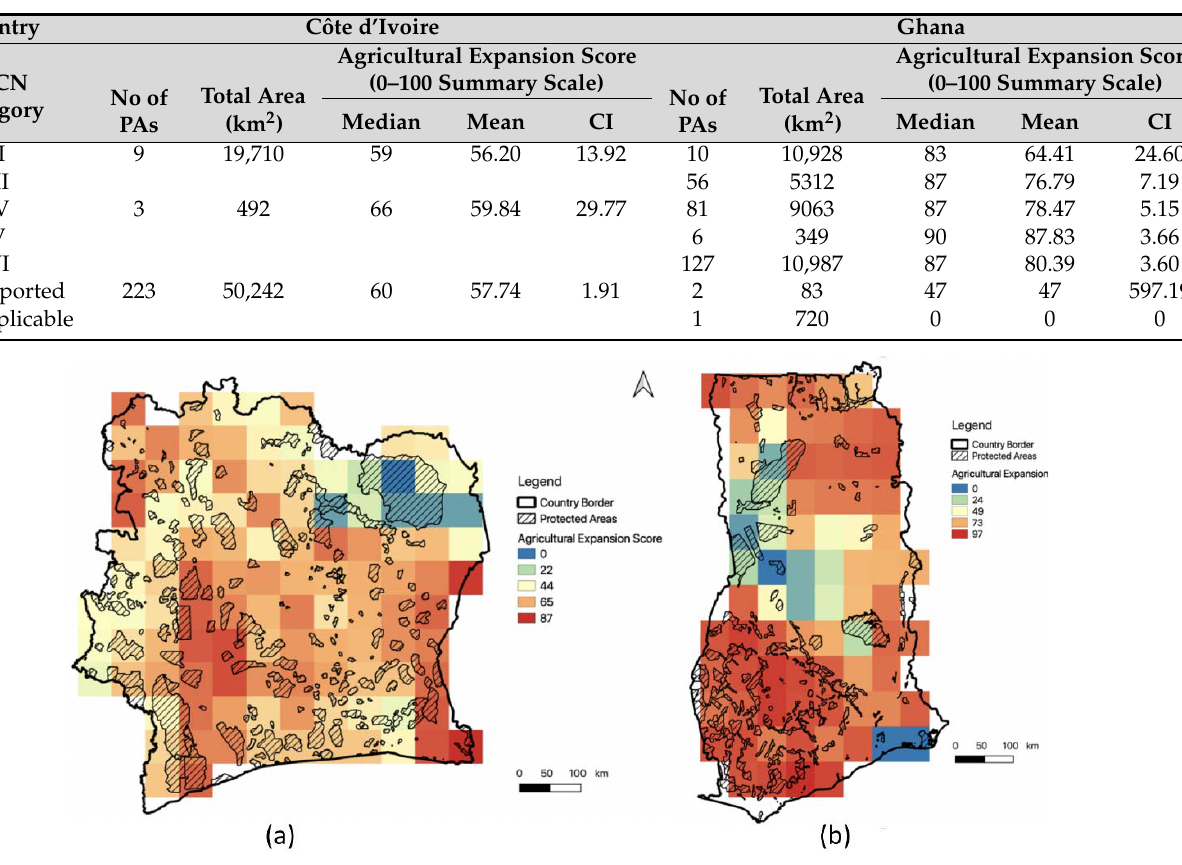
Figure 5. The protected areas and future development threat for agricultural expansion in ( a ) Côte d’Ivoire, and ( b ) Ghana, West Africa. Table 9. Summary statistics (median, mean, and CI for mean value) for the future development threat of agricultural expansion in Côte d’Ivoire and Ghana’s protected areas (IUCN PA categories, those without assigned categorizations (not reported) and World Heritage Sites or UNESCO MAB reserves (not applicable)).